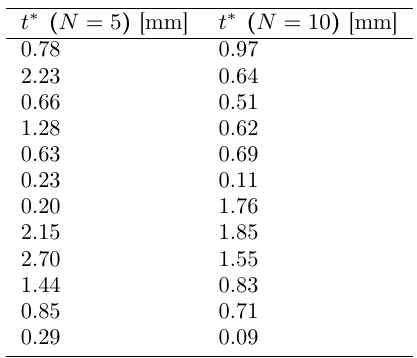
Table 2. Comparison of optimized